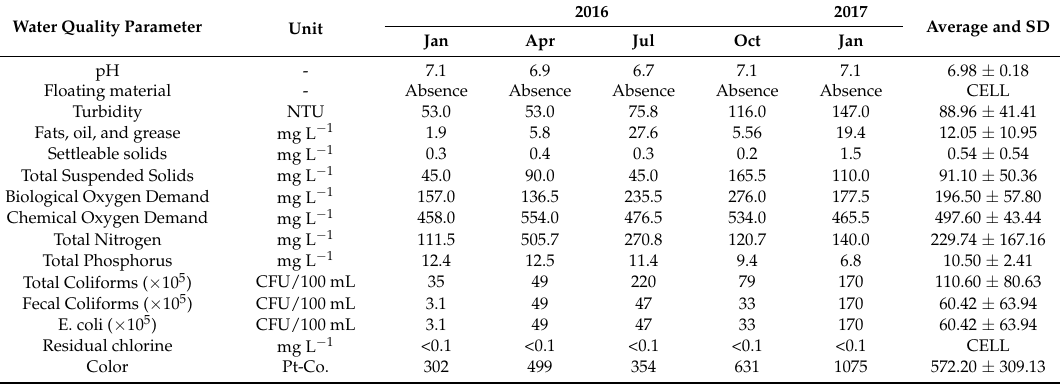
Table 3. Water quality parameters at the outlet of the septic tank (SD = standard deviation). Water Quality Parameter